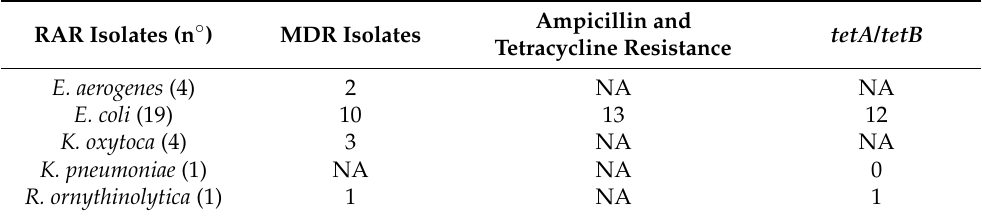
Table 3. Analysis of St. Barth é lemy rare antibiotic resistant (RAR) isolates, according to different impact evaluation strategies. Ampicillin and tetA / tetB RAR Isolates (n ◦ ) MDR Isolates Tetracycline Resistance E. aerogenes (4) 2 NA NA NA NA NA NA